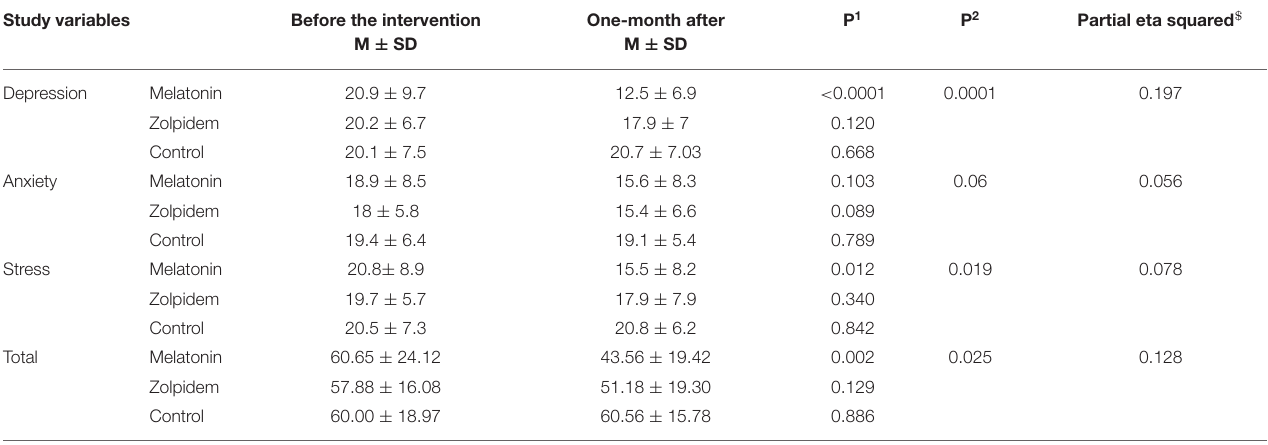
TABLE 3 | Comparison of changes in the scores for mental health domains in the three groups. Study